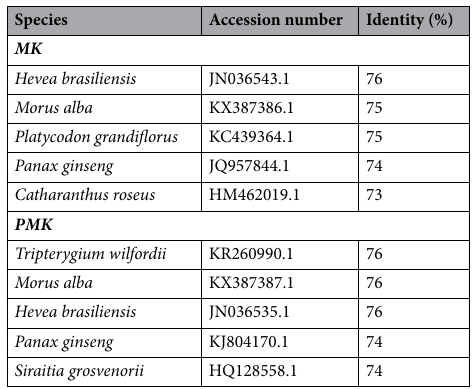
Table 1. Nucleotide sequences of SaMK and SaPMK and similarity to genes from other plant species.